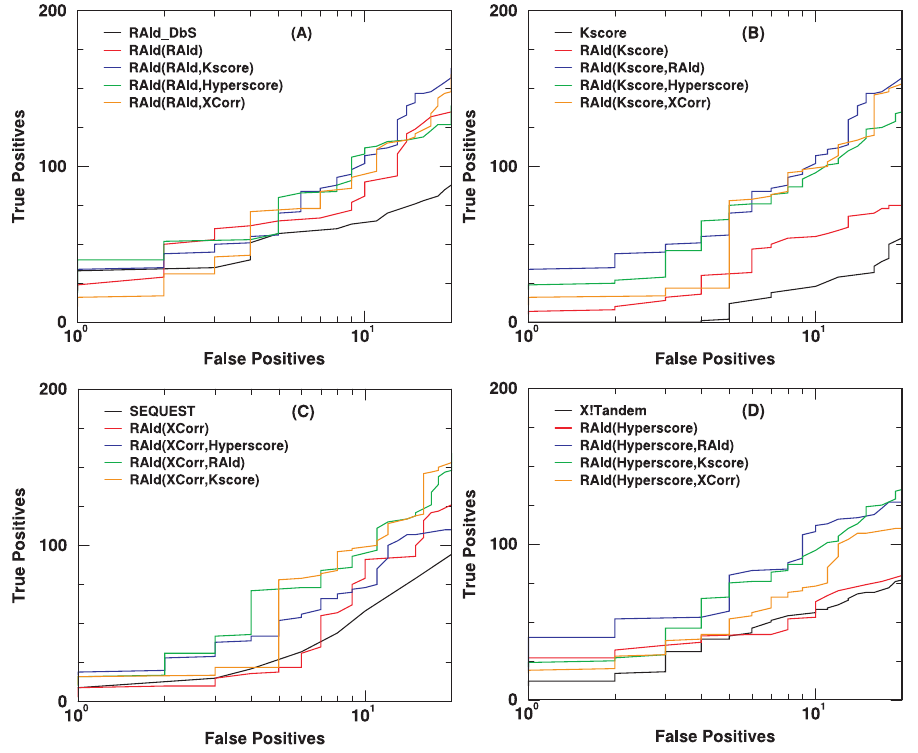
Figure 6. ROC curves for the centroid data (A1–A4 of the ISB data set [ 28 ] ). For each of the four scoring functions considered, a set of ROC curves is shown. These ROC curves include the results from running the designated program associated with that scoring function, the results from running RAId_aPS in the database search mode, and the results from combining with each of the three other scoring functions. Panel (A) shows the results from RAId score, whose designated program is RAId_DbS. Panel (B) displays the results from K-score, whose designated program is X!Tandem. Panel (C) exhibits the results from XCorr, which is mostly employed by SEQUEST. Panel (D) presents the results from Hyperscore, whose designated program is also X!Tandem. Instead of using only XCorr (like RAId_aPS), SEQUEST first selects the top 500 candidates using SP score. As shown in panel (C), for centroid data there is an advantage to filtering candidates with the SP score. However, it is also seen that by combining XCorr with either RAId score or Hyperscore, equally good results can be attained without introducing the SP score heuristics.